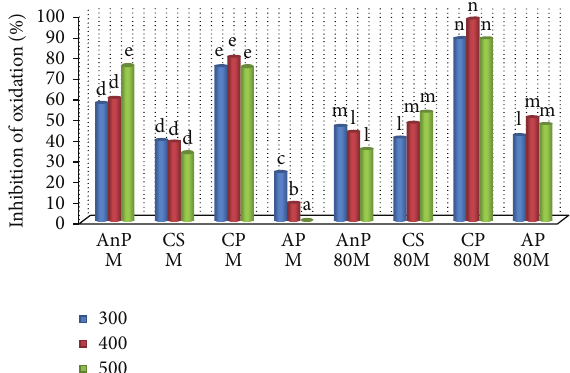
Figure 1: Inhibition of cholesterol oxidation by different plant extracts. AnP: Andrographis paniculata ; CS: Costus speciosus ; CP: Canthium parviflorum ; AP: Abrus precatorius ; M: methanol; 80M: 80% methanol; a, b, c, ... represents significance of methanol extracts, l, m, n, ... represents significance of 80% methanol extracts ( 𝑝 ≤ 0.05 ). Values are the mean of triplicates ( 𝑛 = 3